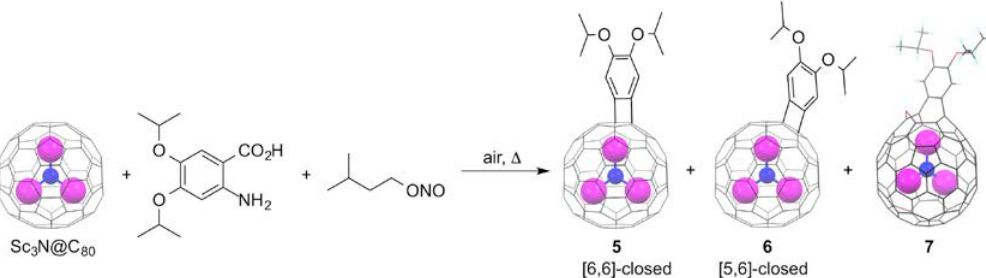
Figure 2. Cycloaddition reaction of Sc 3 N@C 80 with 2-amino-4,5-diisopropoxybenzoic acid and isoamyl nitrite, to produce open-cage metallofullerene 7.